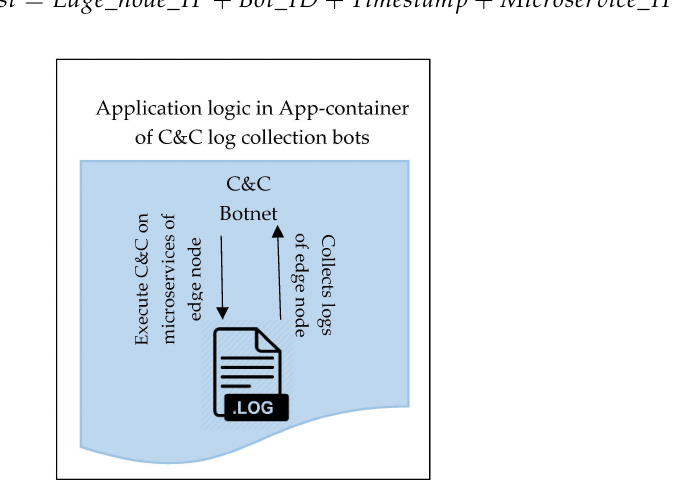
Figure 10. C&C bots running inside